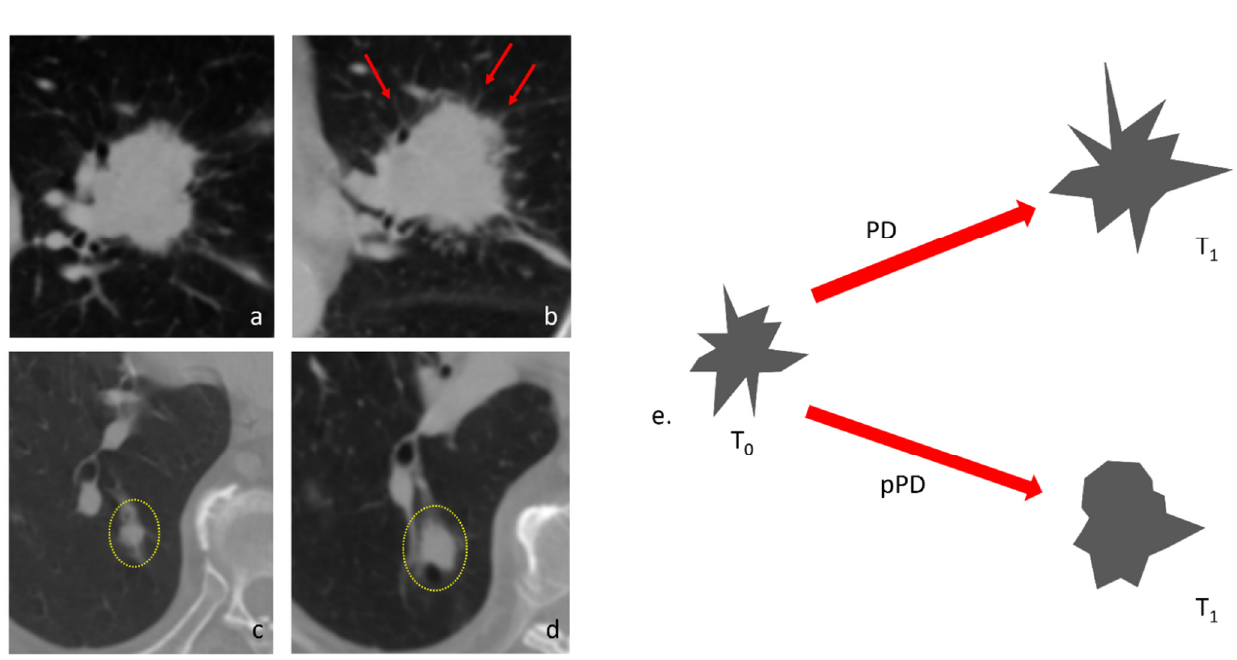
Figure 6. Examples of changes in Short Run Low Gray-Level Emphasis. ( a ) A tumor in the left upper lobe that undergone PD after immunotherapy ( b ). At the first re-evaluation, many spicules are appreciable on the boundaries of the tumor (red arrows), indicating a more infiltrative patterns, In this case, the value of SRLGLE presented a relative variation of −0.59617207. ( c ) A tumor in the right lower lobe (yellow dotted circle) presented a discrete enlargement after immunotherapy ( d ), a finding that might indicate PD; however, during follow-up the nodule shrunk, a behavior consistent with pPD. In this case, ∆-SRLGLE was 1.189415458 due to a decisive decrease of SRLGLE. ( e ) The changing of SRLGLE in PD and pPD is depicted in this scheme with exemplificative purposes: in PD the spiculae on the boundaries of tumor increase significantly and contribute to creating new small, low-density interfaces that increase the value of SRLGLE. In pPD, despite the volumetric enlargement of the nodule, the boundaries become more rounded, reducing the presence of small interfaces.